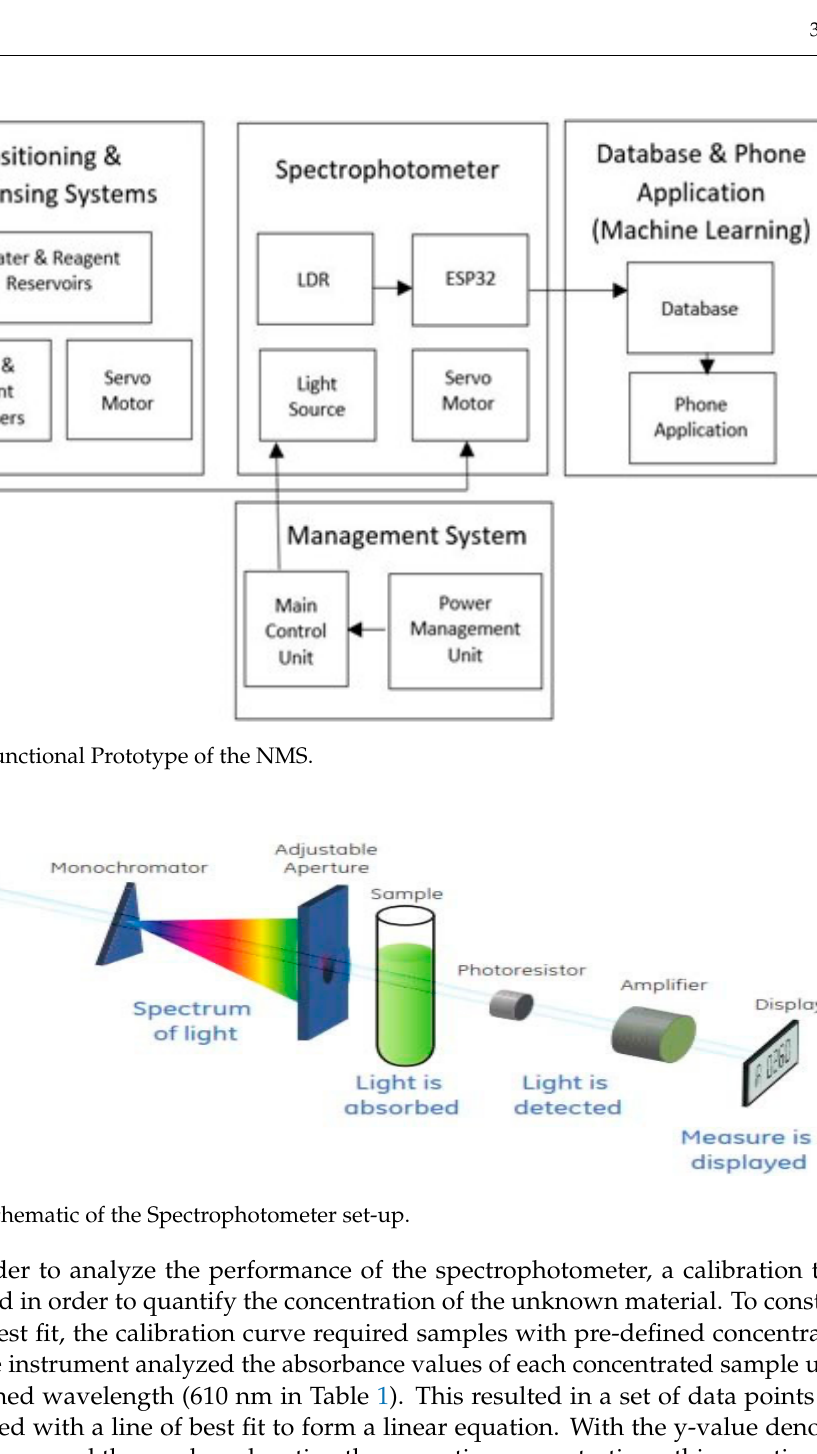
Figure 2. Schematic of the Spectrophotometer set-up.